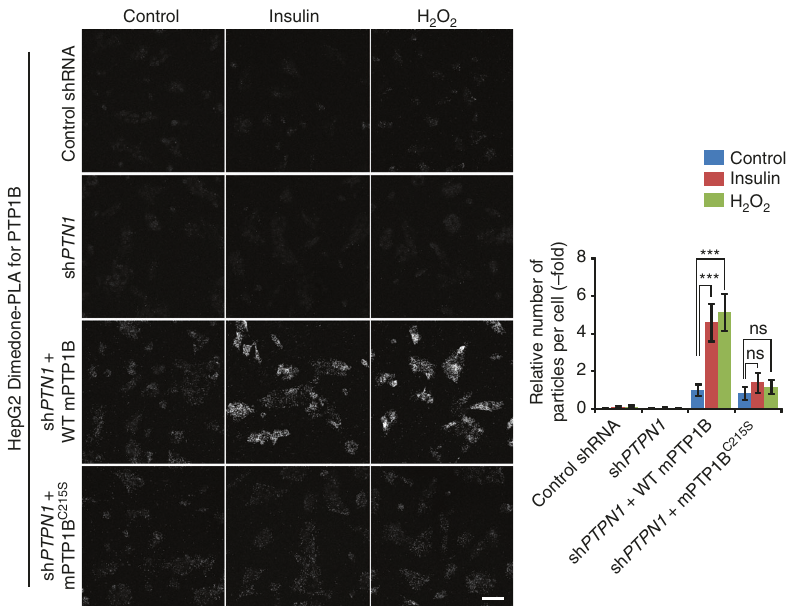
Fig. 2 Detection of oxidized PTP1B by dimedone-PLA. Serum-starved HepG2 cells expressing control shRNA or shRNA targeting human PTPN1 (sh PTPN1 ), with or without stable expression of either mouse WT PTP1B or PTP1B C215S , were stimulated with insulin (25 nM) or H 2 O 2 (1 mM) for 5 min or left unstimulated. Cells were then subjected to dimedone-PLA with anti-dimedone-Cys and anti-mouse PTP1B antibodies ( gray ). Representative images are shown for each condition from one of two independent biological replicates. The graph shows the average number of PLA signals per cell ( n = 6 images for each condition, 80 – 120 cells in an image), relative to control cells without stimulation (set as 1). *** P < 0.0001, ns not signi fi cant, ANOVA with Bonferroni/ Dunn ’ s post-hoc test. Error bars represent SD. Scale bar : 50 μ